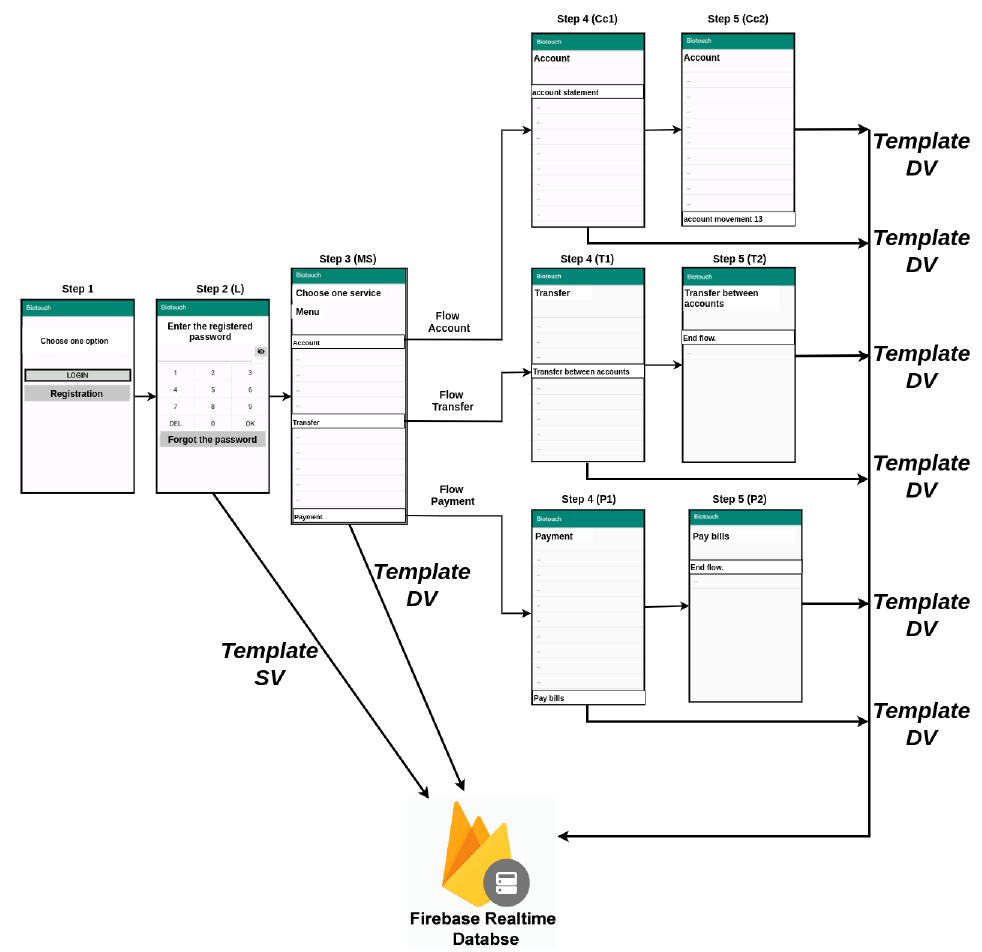
Figure 3. Biotouch app screens for the application